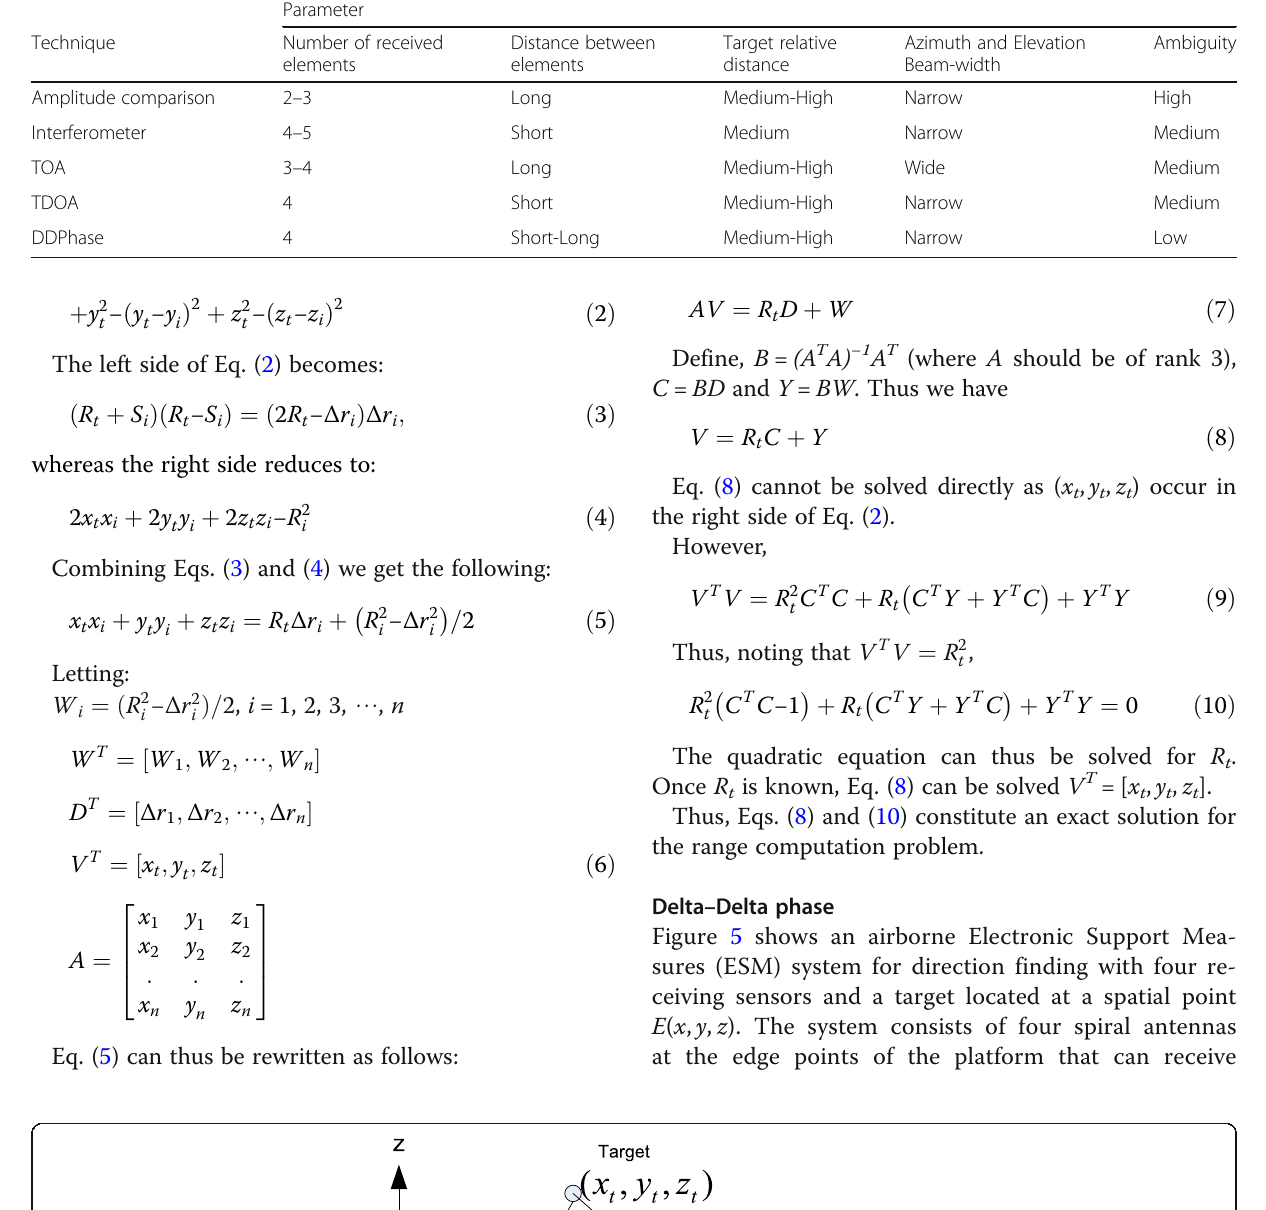
Table 1 Direction-finding measurement techniques comparison